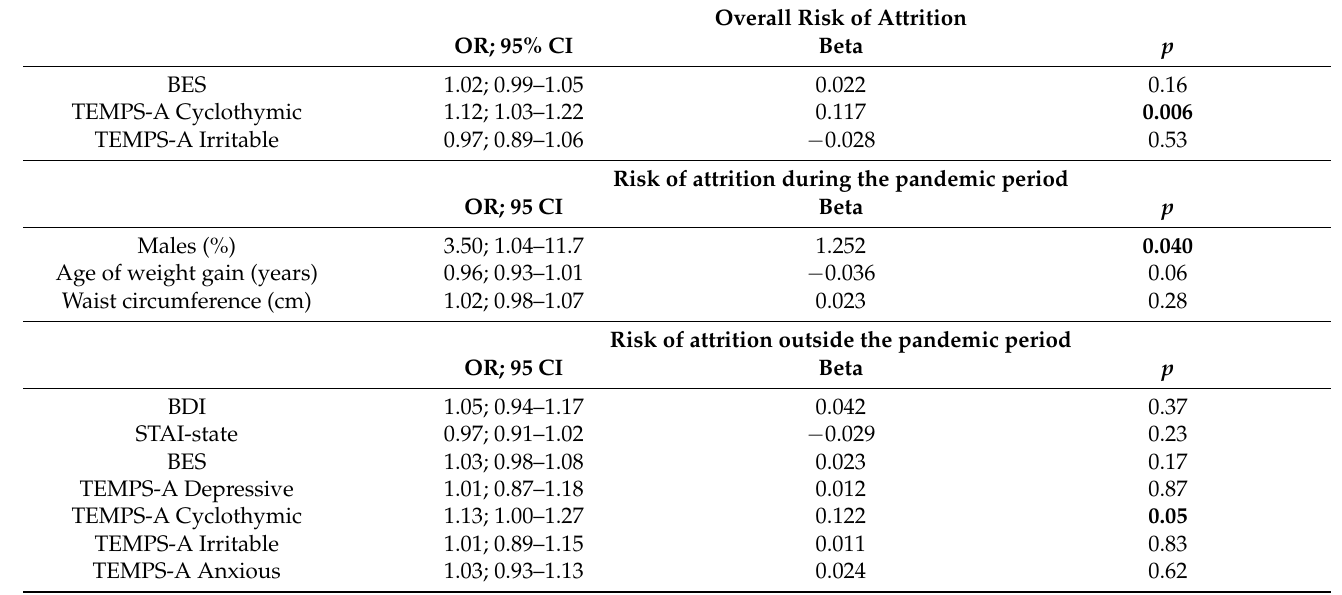
Table 3. Variables associated with the risk of attrition by the period of attendance to the obesity unit in a multiple logistic regression